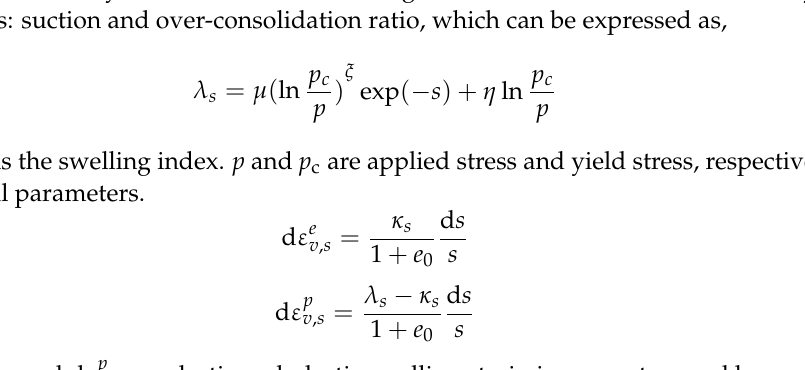
Figure 9. The initial swelling indexes on the free ‐ swelling curves, swelling parts of the swelling curves, and swelling ‐ collapse curves.